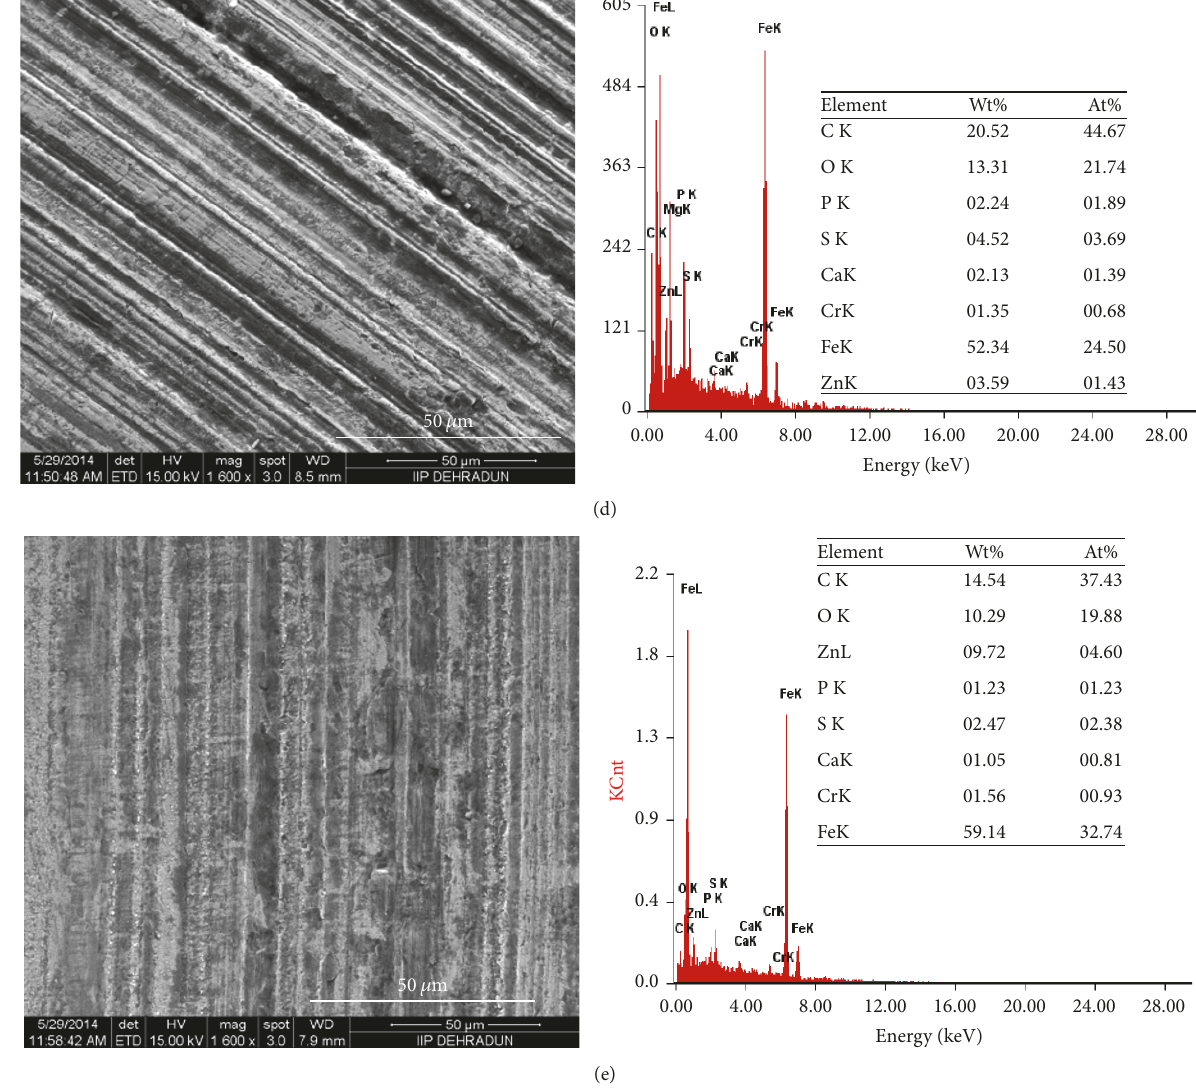
Figure 8: SEM/EDX micrographs for the lubricants (a) L 1 , (b) L 2 , (c) L 3 , (d) L 4 , and (e) L 5